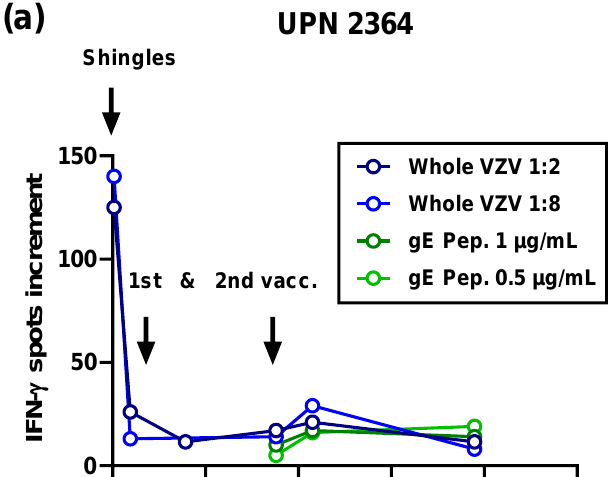
7 of 17 Figure 2. Individual time courses of varicella-zoster virus-specific immunity in hematopoietic stem cell transplant recipients tested prior to and post second vaccination with the adjuvanted, recombi- nant zoster vaccine Shingrix™. In this cohort, blood sampling was performed at a median of 33 months after transplantation. Vacc-vaccination with Shingrix™; Whole VZV-whole varicella-zoster